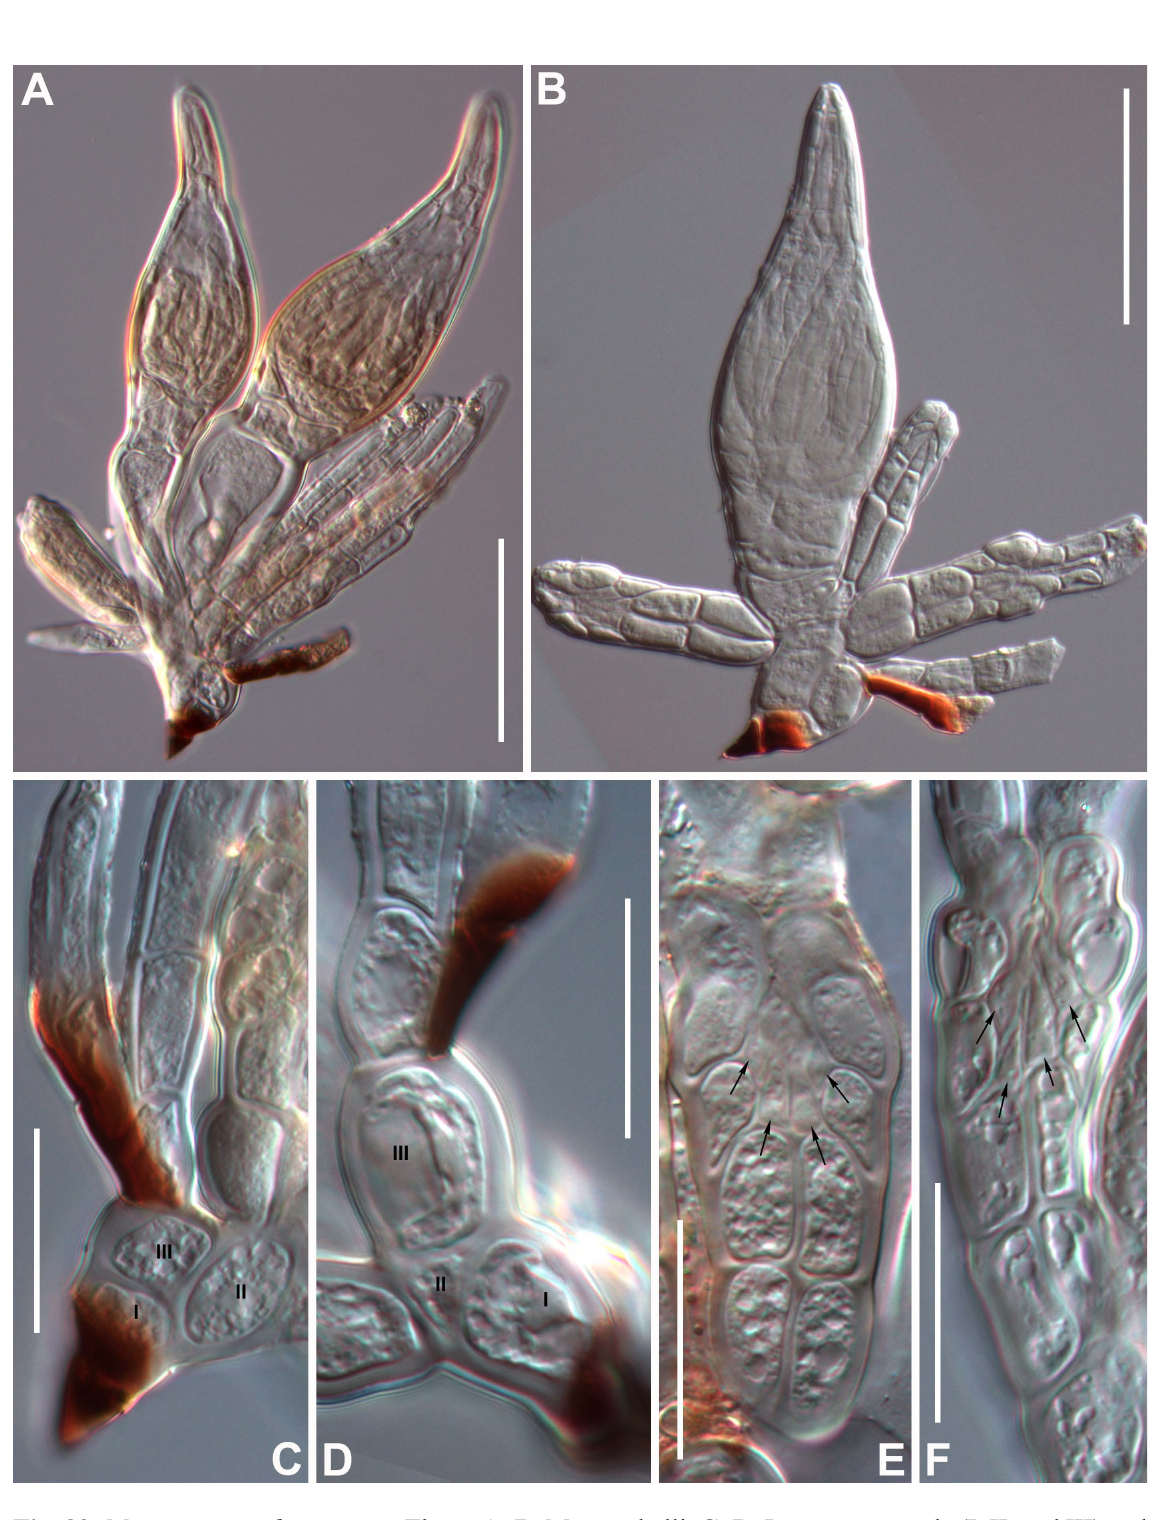
Fig. 82. Monoicomyces britannicus Thaxt. A – B . Mature thalli. C – D . Lower receptacle (I, II, and III) and base of primary appendage in detail. E – F . Antheridia showing four phialides in focus (arrows). Scale bars: A–B = 50 µm; C–F = 20 µm. Photographs from slides ZMUC C-F-123462 (A, C, E), ZMUC C-F- 122513 (B), ZMUC C-F-123480 (D,